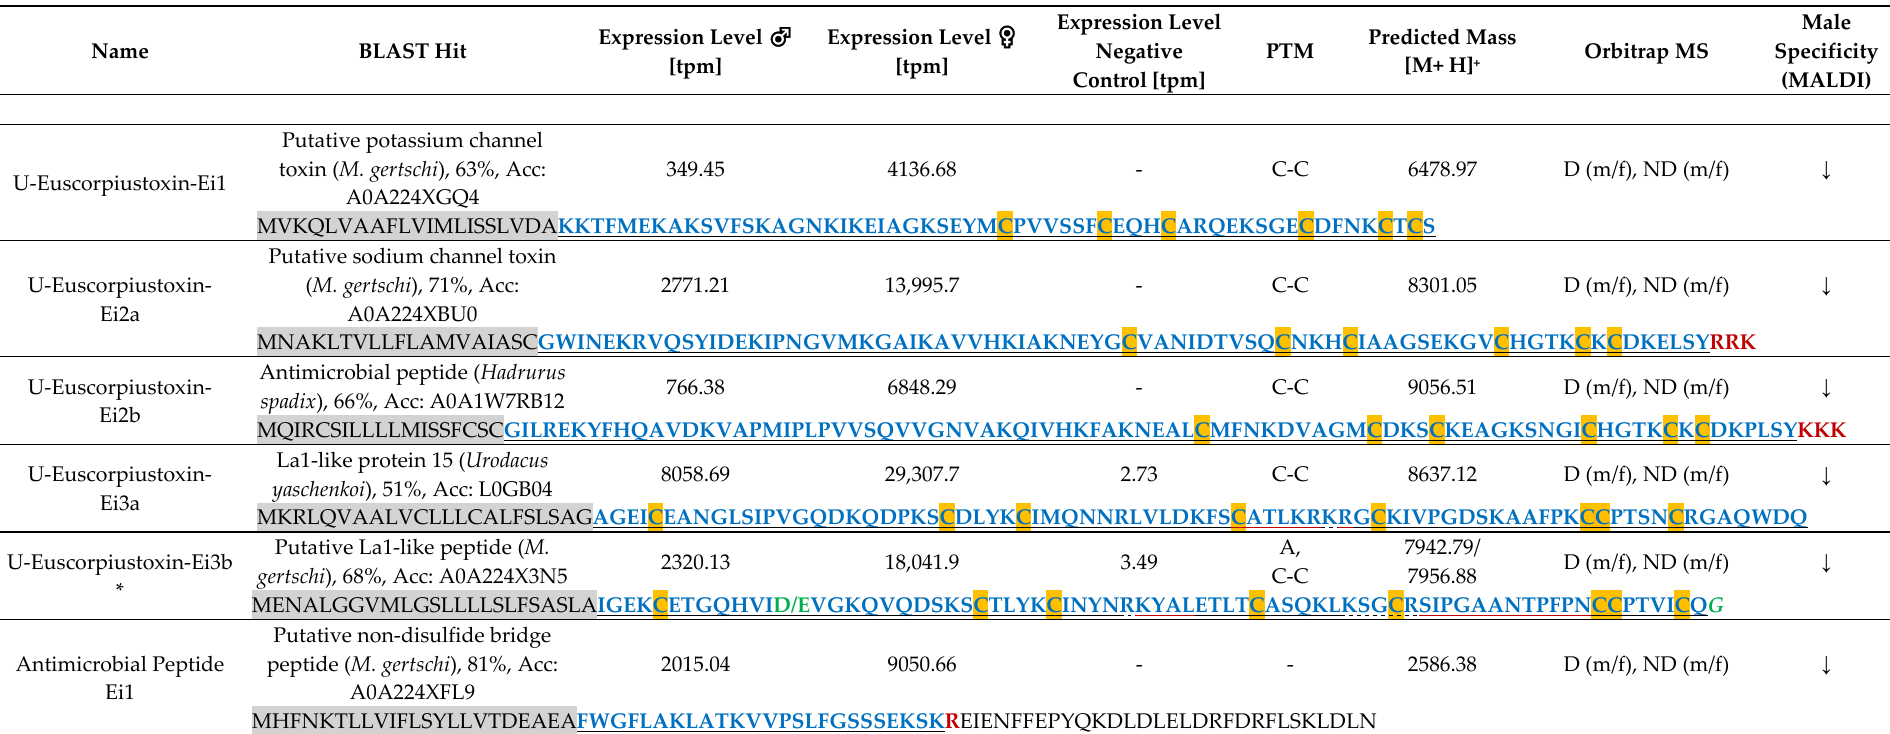
Table 1. Information on venom precursors up- [ ↑ ] or down-regulated [ ↓ ] in males of E. italicus . Specificity was assessed based primarily on repeatedly generated MALDI-TOF mass spectra of venom samples from both sexes and juveniles but was also supported by the statistically less significant transcriptomic and Quadrupole Orbitrap MS experiments. Precursors were identified by a combined proteomic and transcriptomic approach. Grey, signal peptide; blue letters, potential bioactive peptide; green and italic, amidation signal; yellow, cysteine (half of the disulfide bond); red letters, cleavage site. Black underlined, confirmed by MSMS; red underlined, confirmed only by MSMS of digested samples; dashed line, mass match in MALDI-TOF MS. The column Orbitrap MS indicates which of the four analyses confirmed the precursor sequence. D, digested samples; ND, samples without digestion; m, venom from males; f, venom from females. Assumed PTMs include amidation (A) and disulfide bridges (C–C).